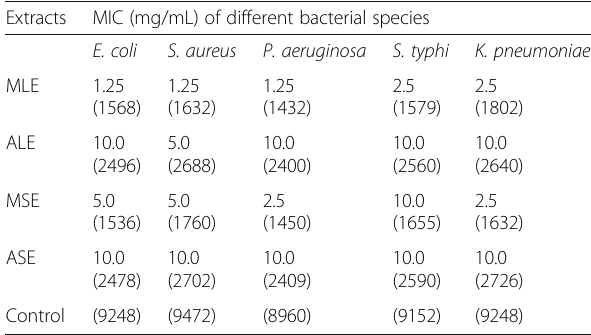
Table 2 Minimum inhibitory concentration (MIC) extracts of